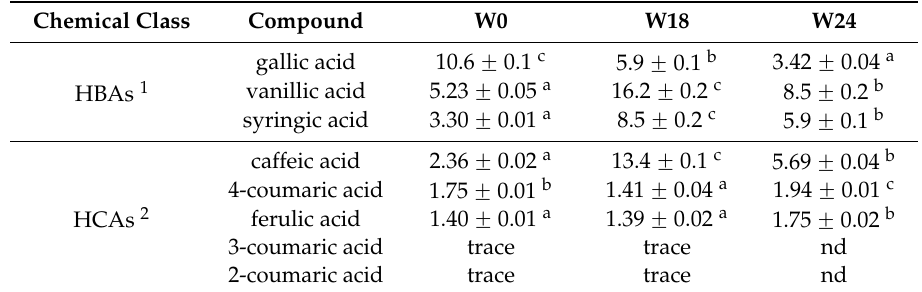
Table 3. Concentration (mg/L) of phenolic compounds determined by HPLC-DAD in the analysed wines (mean ˘